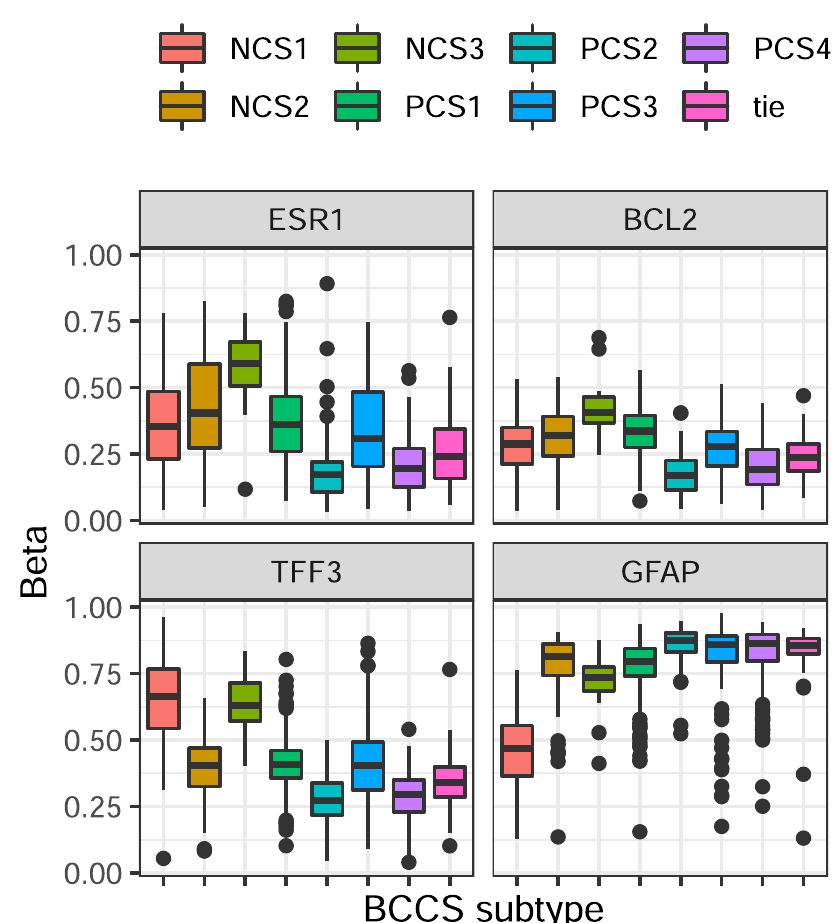
Fig. 7 Distribution of methylation levels for selected genes by BCCS subtypes in BRCA. Methylation Beta values are displayed for promoter regions of ESR1 (cg15626350), BCL2 (cg24408313), TFF3 (cg04806409), and GFAP (cg21944455). The midline in a boxplot indicates the median, the upper and lower edges indicate the quartiles, and the whisker lines are 1.5 times the interquartile